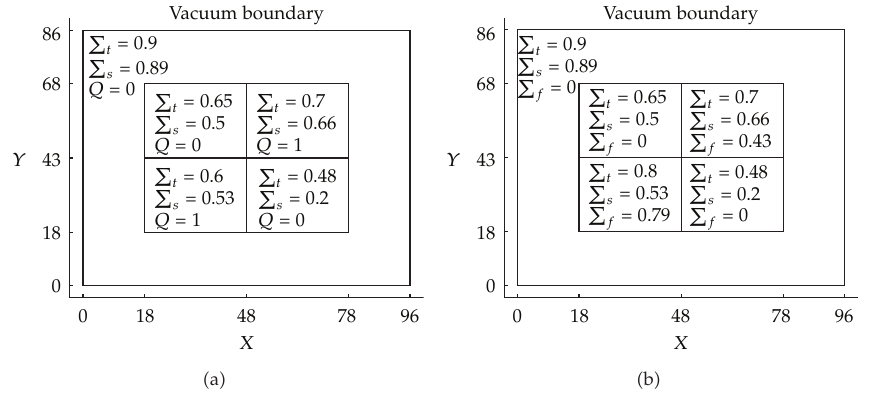
Figure 13: EIR-2A and EIR-2B benchmark problems with data as in Table 2.